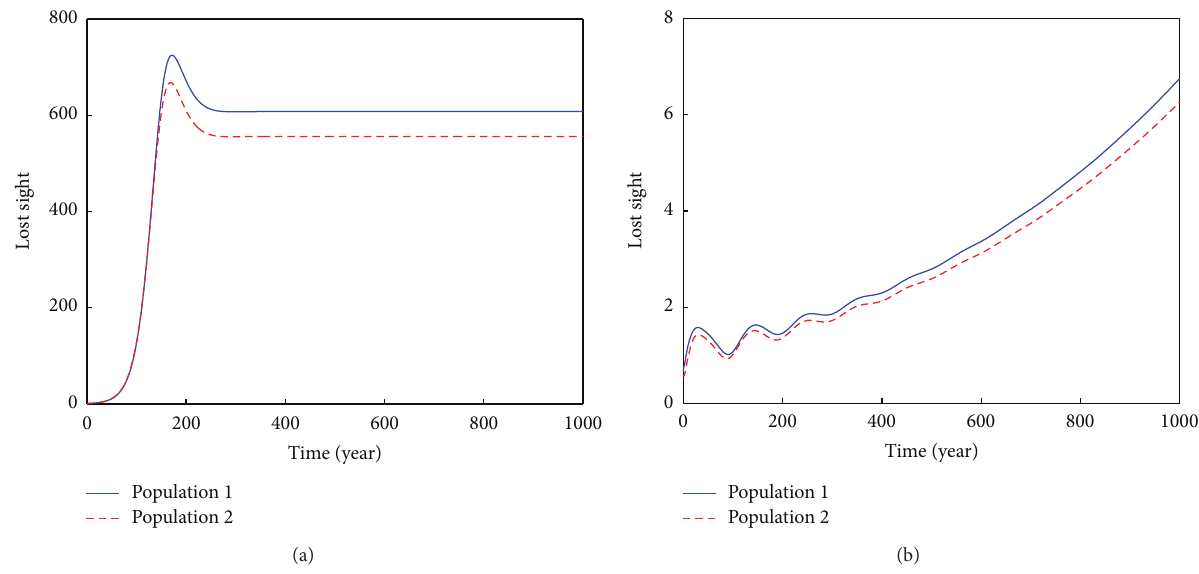
Figure 9: (a, b) Trajectories of lost sight individuals of (1) for different initial conditions. The endemic equilibrium exists and is stable when > 1 ; the DFE is unstable in this 𝑅 0